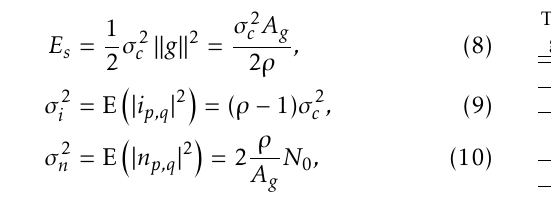
Table 1. Proprietiesof the generators used in oursimulations.